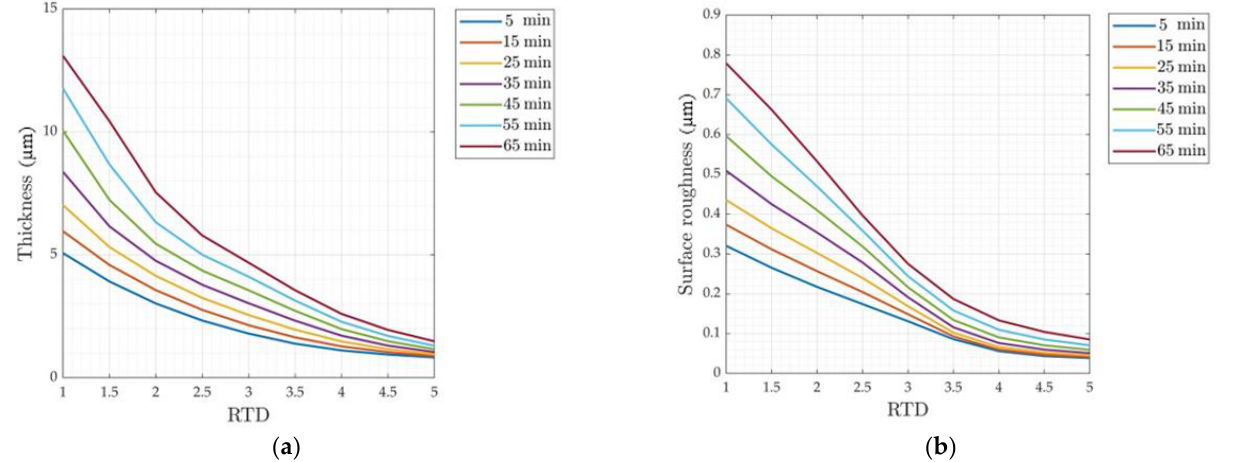
Figure 9. The results of the NN prediction on the effect of the RTD at the current density of 20 mA/cm 2 , stirring speed of 220 rpm, and beam width of 50 μm , relative to ( a ) thickness of nickel coated layer; ( b ) surface roughness of nickel coated layer.